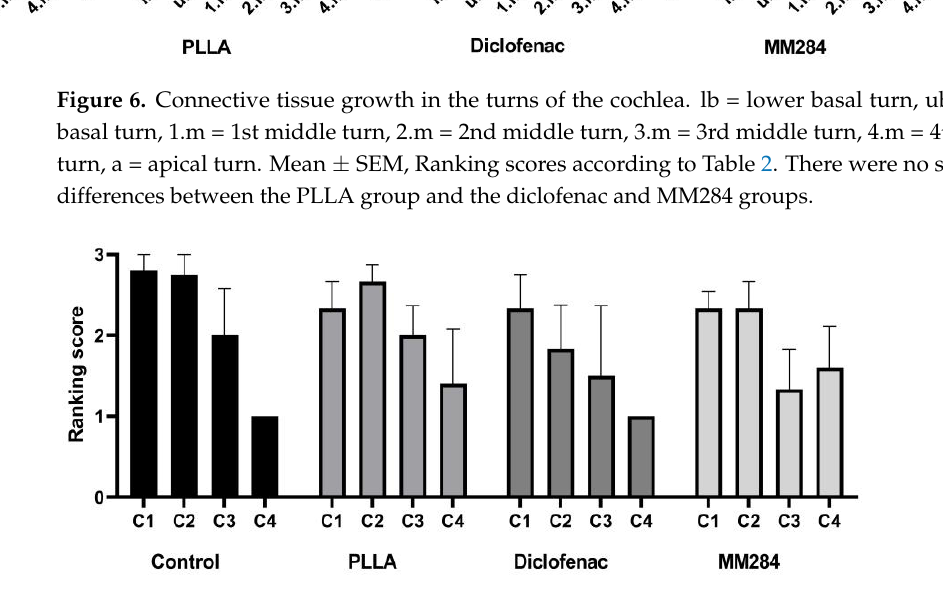
Figure 7. Tissue growth around the contacts, C1 = contact 1, C2 = contact 2, C3 = contact 3, C4 = contact 4, Mean ± SEM, no differences between groups were detected. Ranking score: 0 = no connective tissue, 1 = thin film of fibrosis directly on the contact, 2 = reticular growth of connective tissue on the contact, 3 = contact completely covered by compact connective tissue.